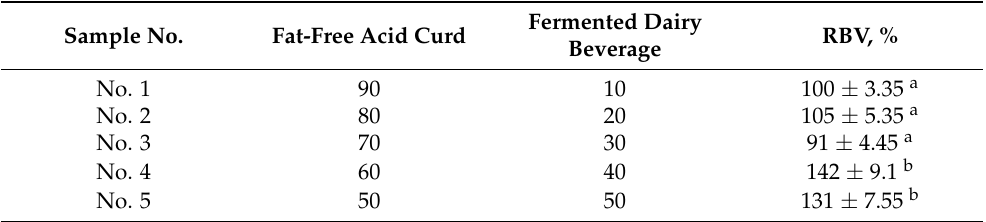
Table 8. Curd product samples’ components. a,b : Different letters mark sample groups with statisti- cally distinguishable RBV mean values.